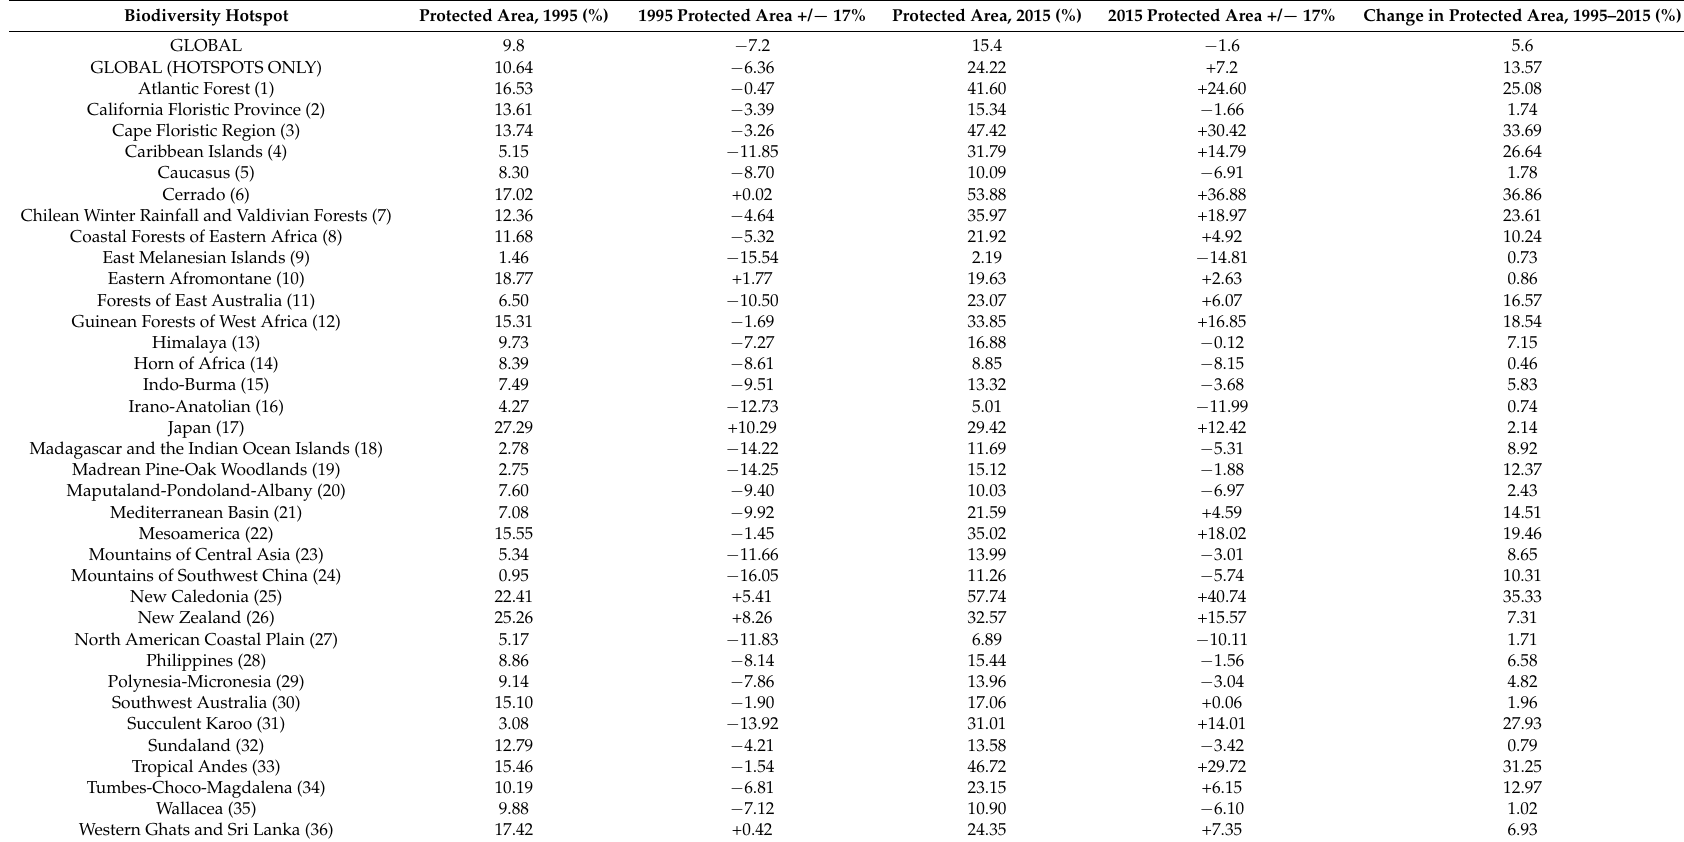
Table A2. Protected Area Data for Biodiversity